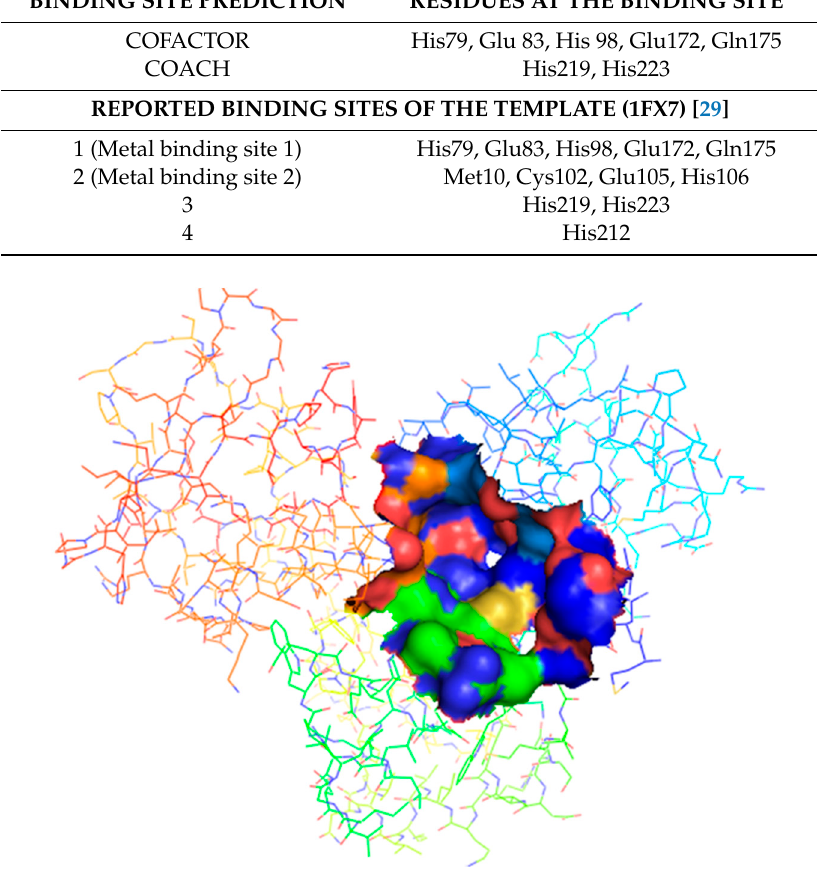
Table 2. Summary of predicted binding sites of the model and reported binding sites of the template (1FX7, ideR from M. tuberculosis ) and those predicted for the model via COACH and COFACTOR.